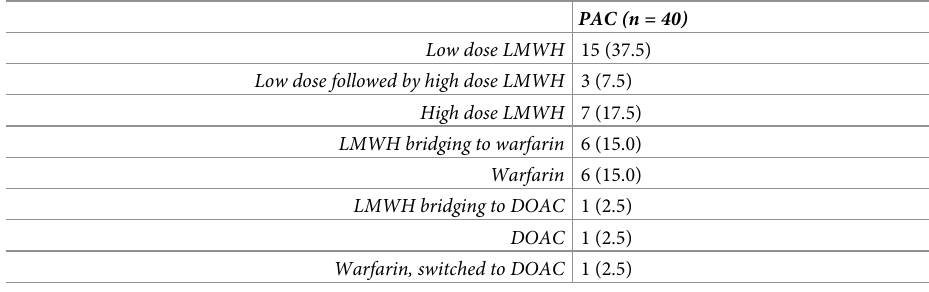
Table 3. PAC regimes.